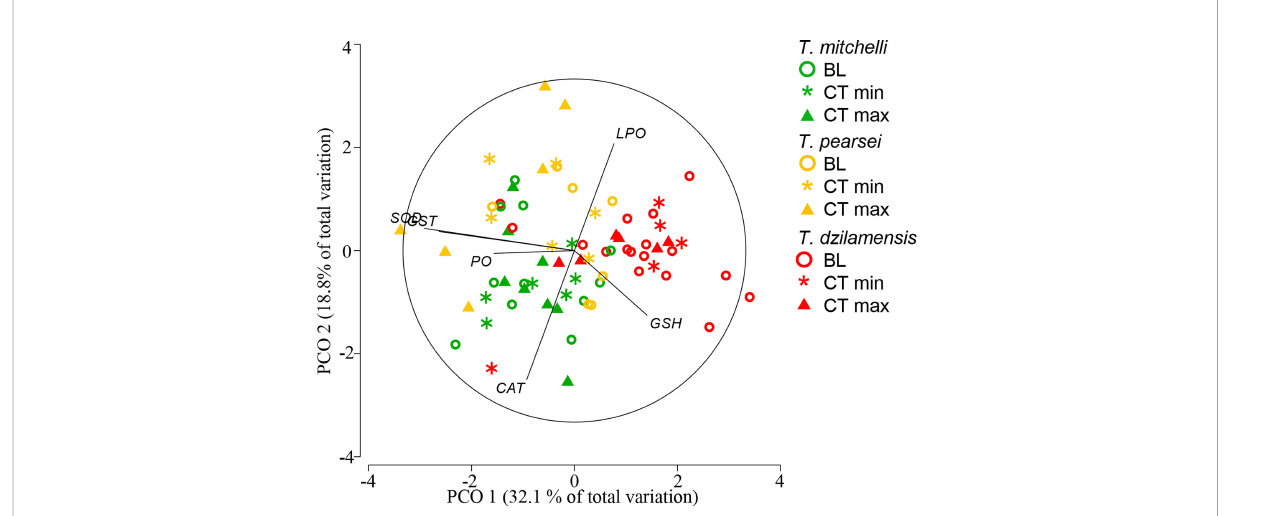
FIGURE 5 Principal coordinate analysis (PCoA) of antioxidant system indicators [Catalase (CAT), Glutathione S-transferase (GST), total Glutathione (GSH) and Superoxide dismutase (SOD)] and cellular damage [protein carbonylation (PO) and lipid peroxidation (LPO)] of T. mitchelli , T. pearsei and T. dzilamensis individuals sampled at the end of the critical thermal limits procedures (CTmax and CTmin), and compared to baseline (BL) individuals.